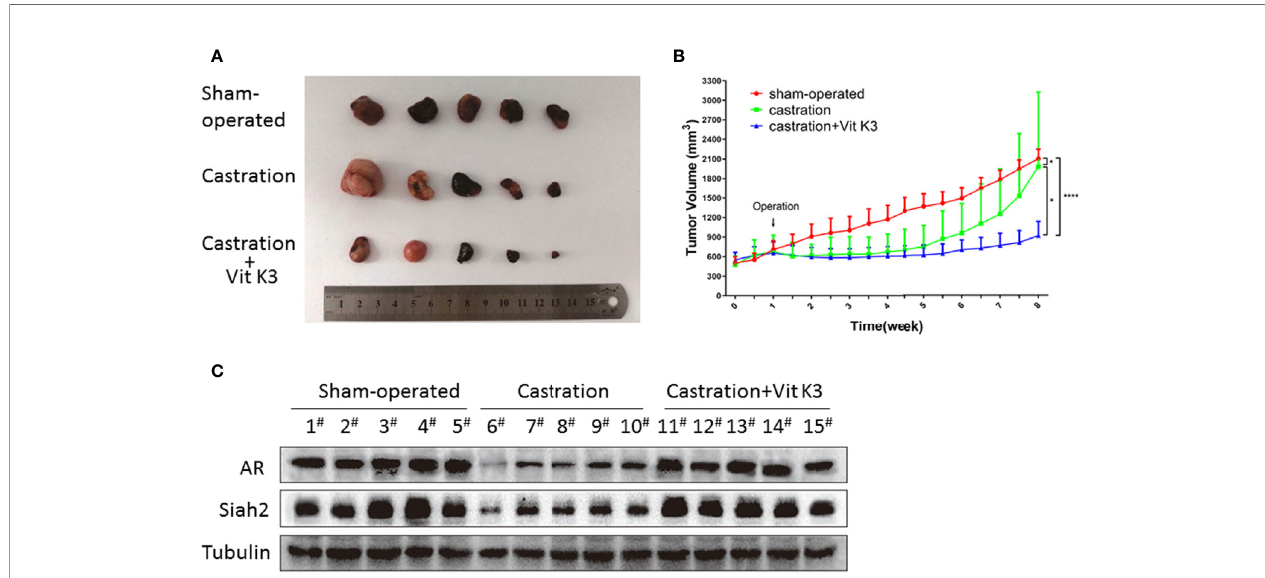
FIGURE 5 | ADT combined with Vit K3 therapy delayed the formation of CRPC. (A) LNCaP cells were subcutaneously injected into BALB/c nude mice, and the animals were treated as described in the Materials and Methods. The tumor xenografts with different treatments are shown as indicated. (B) The growth curve of tumor xenografts. (C) Xenograft tumor tissue lysates were analyzed by Western blotting to detect AR and Siah2 expression in the sham-operated, castration, and castration+Vit K3 groups. *P < 0.05, ****P <